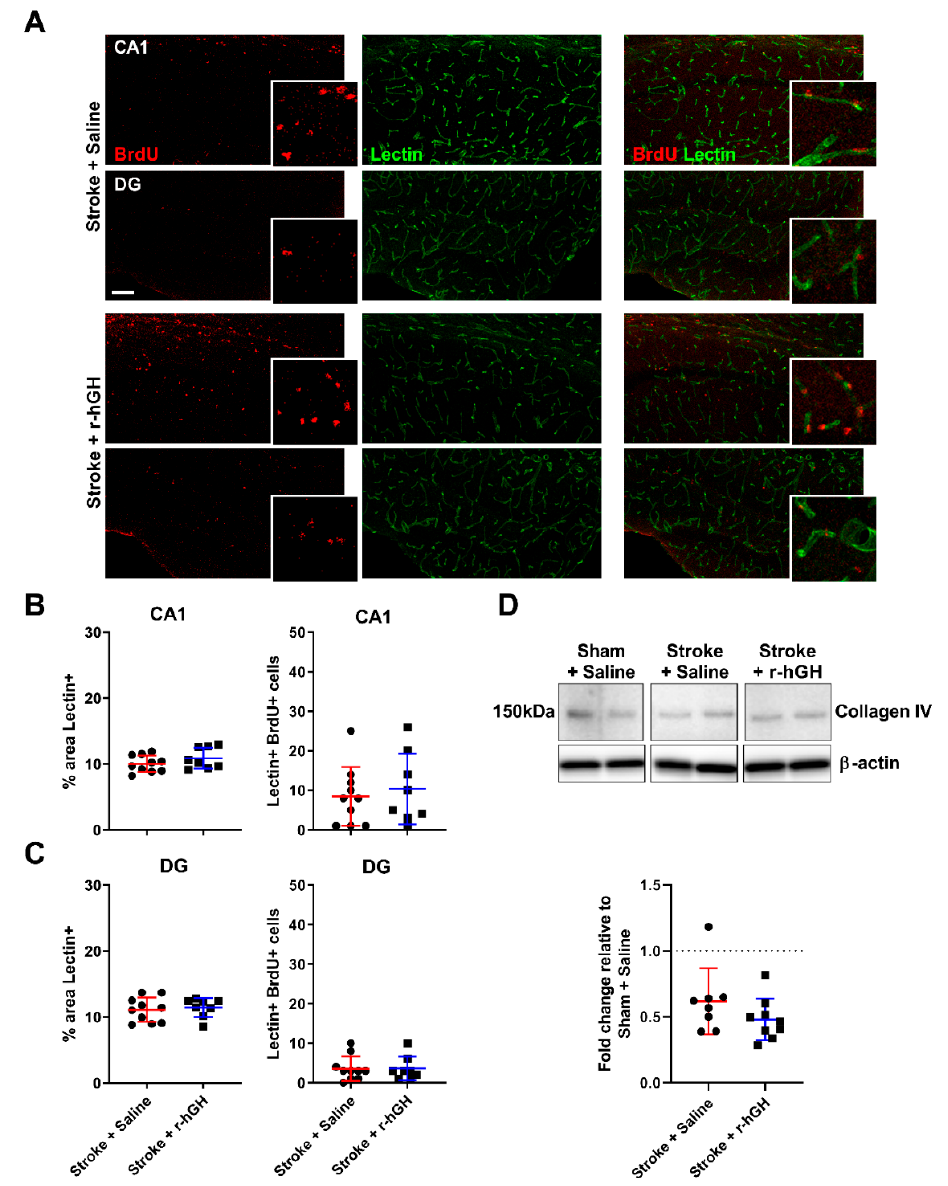
Figure 4. Analysis of cerebrovascular remodeling within the hippocampus region. ( A ) Representative immunofluorescence images of BrdU (red) and tomato lectin (green) and high magnification detail (scale bar = 100 µ m) in the CA1 and DG subregion of the hippocampus. ( B ) Quantification of the number of BrdU-lectin-positive cells and % of area covered by tomato lectin in the CA1. ( C ) Quantification of the number of BrdU-lectin-positive cells and % of area covered by tomato lectin in the DG. There were no significant di ff erences in any of the parameters between stroke mice treated with r-hGH and the saline group. ( D ) Representative western blot and Collagen IV protein levels in the hippocampus. For full immunoblots, see Figure S1. Mean ±